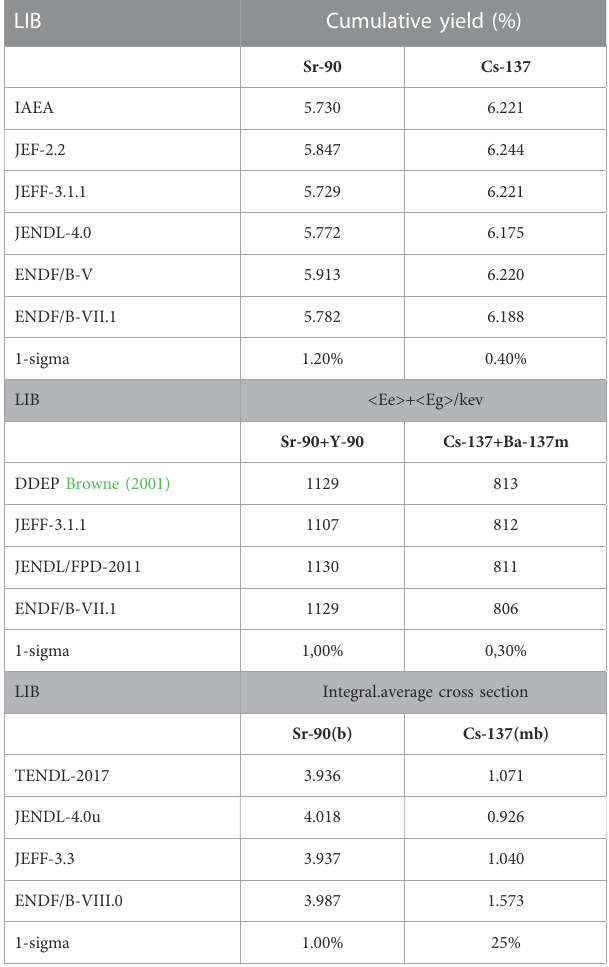
TABLE 1 Simple estimate of uncertainty regarding yield, decay energy (beta plus gamma emission) and neutron capture cross section of 137 Cs and 90 Sr of different microscopic data libraries. The “ 1-sigma ” value is derived from the sample variance of each preceding column.